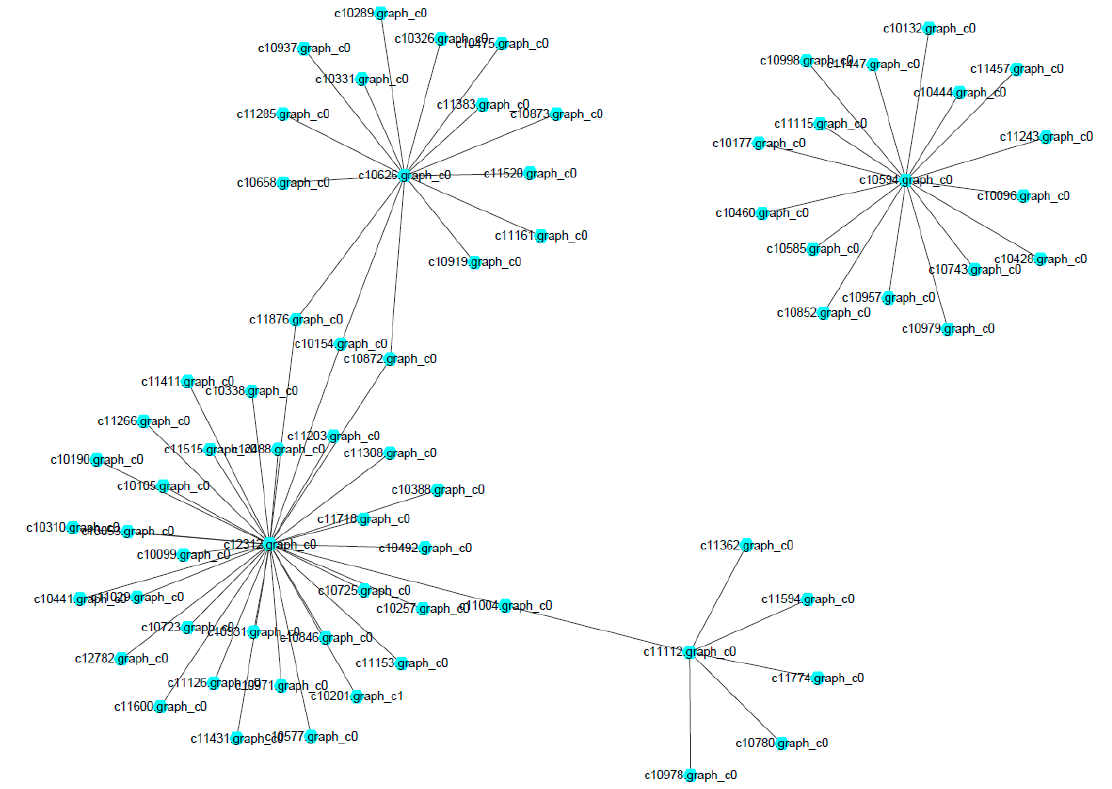
Figure 8. Protein interaction networks in M. roridium transcriptome.